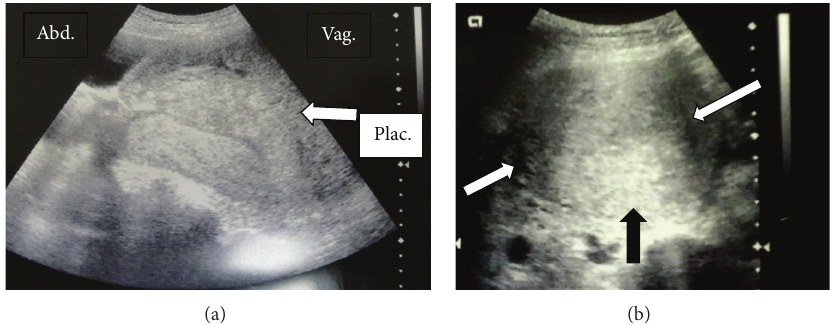
Figure 1: (a) Transabdominal sagittal sonogram showing a mirror image of the uterus with the endometrial pseudostripe represented by the two opposing serosal surfaces [5]. The placenta that adhered to the fundus can be seen on the vaginal side (white arrow). (b) Transabdominal transverse sonogram showing the target sign with the hyperechoic inverted fundus centrally (black arrow) surrounded by hypoechoic fluid (white arrow) between the fundus and vaginal wall